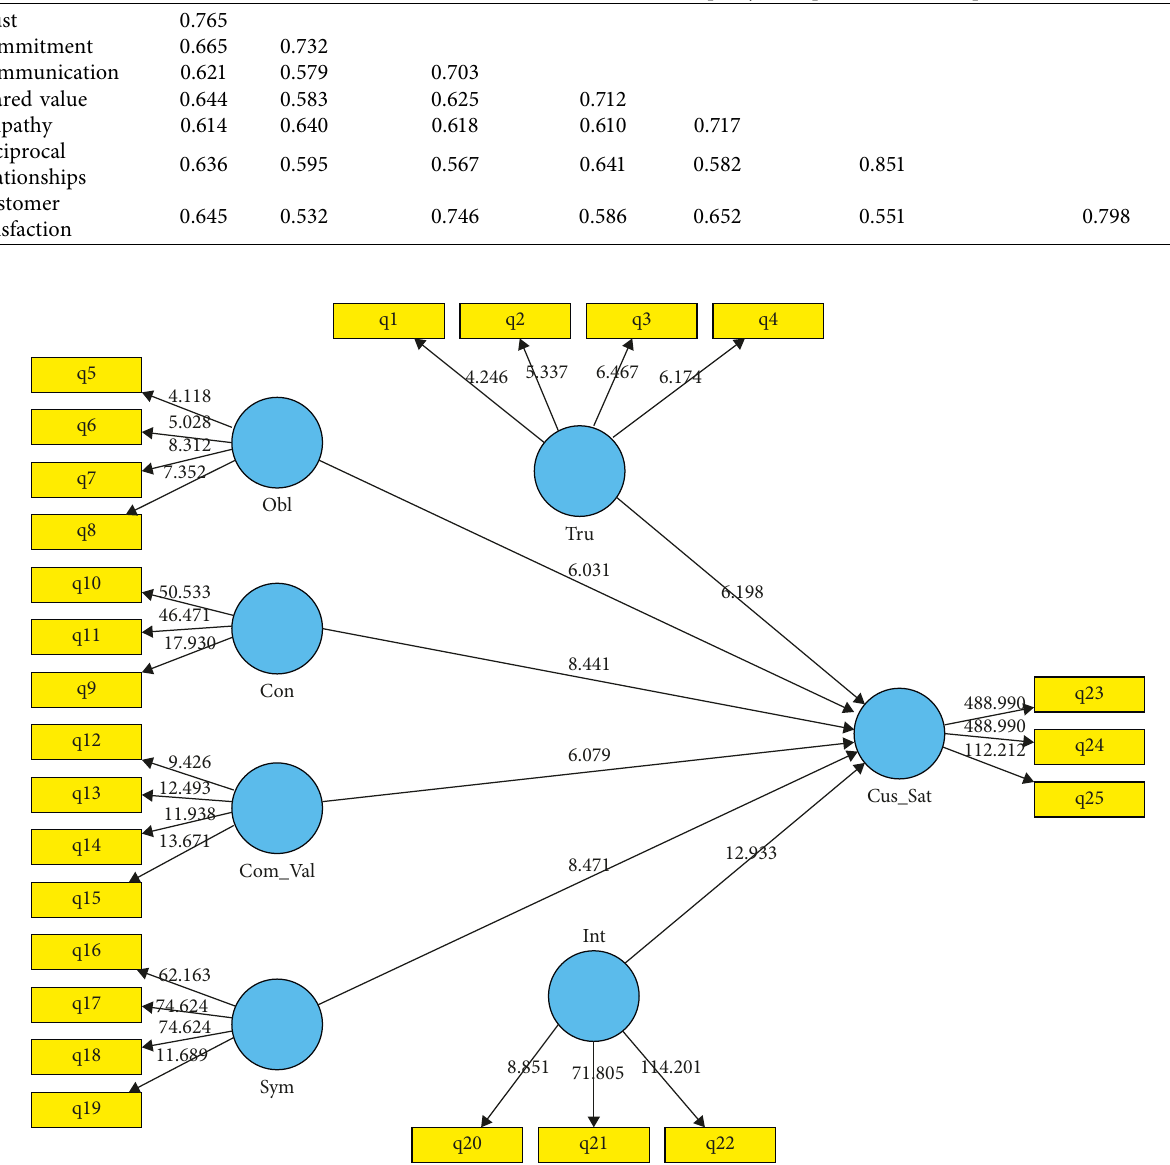
Figure 3: Structural equation model of the research in the mode of significant coefficients of